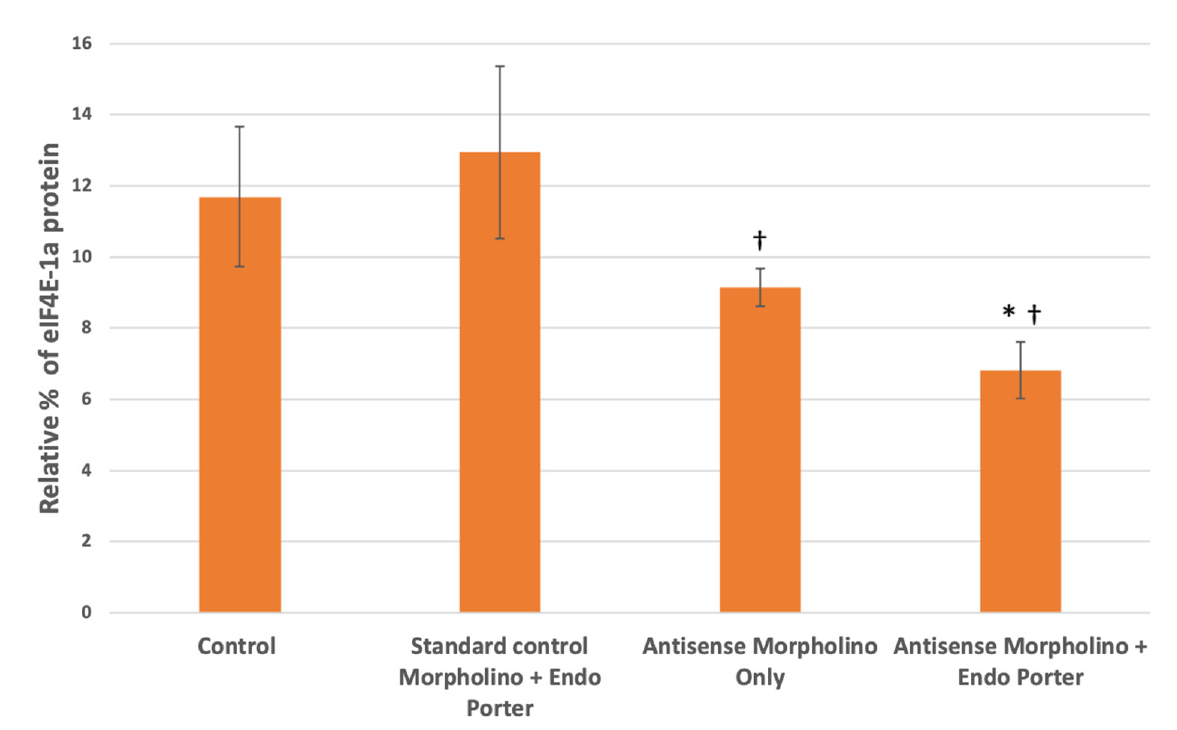
Figure 5. Western blot analyses for eIF4E-1a concentrations within control and treated cells at 48 post-MO [10 µ M] addition (N = 3). Protein loading and relative expression levels was veri-fied by probing with anti-eIF4E-1a mouse monoclonal and HRP-conjugated anti-mouse IgG and compared to total protein volumes. Relative eIF4E-1a levels are lower in Am-phidinium population after 48 h of being subjected to custom translation-blocking morpholinos. Statistical analysis was done using t -tests with pooled standard deviations. * Significantly different from ‘Control’ based on a p -value of < 0.05. † Significantly different from “Standard Morpholino + Endo Porter” based on a p -value of < 0.05. No significant difference found between “Antisense Morpholino Only” and “Antisense Morpholino + Endo Porter” based on a p -value of < 0.05. Table 1. Volume of eIF4E-1a produced compared to the control. Volumes of eIF4E-1a were quantified via western blot and compared to the density of a whole protein stain per sample (N = 3). Percent of eIF4E-1a for each sample were compared to the control sample to describe relative eIF4E-1a production. Statistical analysis was done using t -tests with pooled standard deviations.